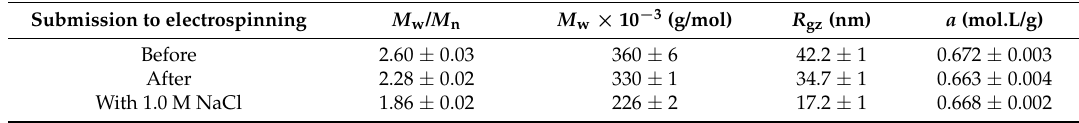
Table 2. Molecular characteristics of 8%